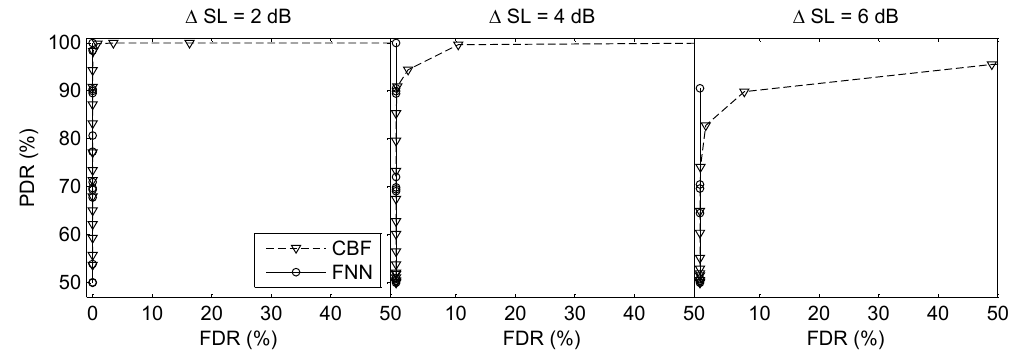
Figure 11. ROC curves of direction finding when the SLs of two testing sources are different in the two-source scenarios. The SNR of the dominant source was 5 dB. ∆ SL = SL 1 − SL 2 (dB) (SL 1 corresponds to the dominant source and SL 2 corresponds to the weak